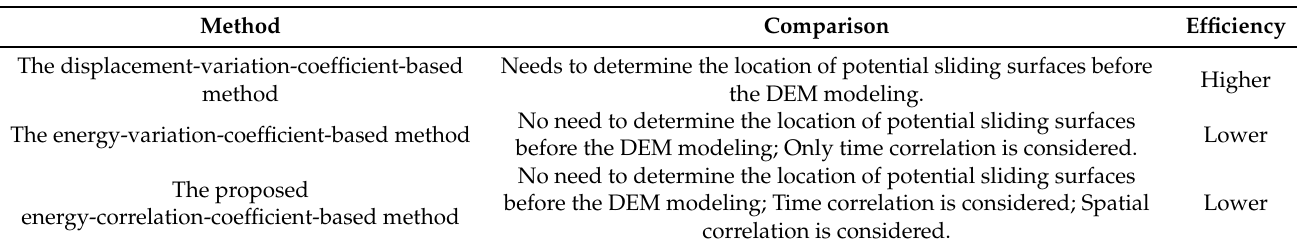
Table 4. The comparison of the mentioned